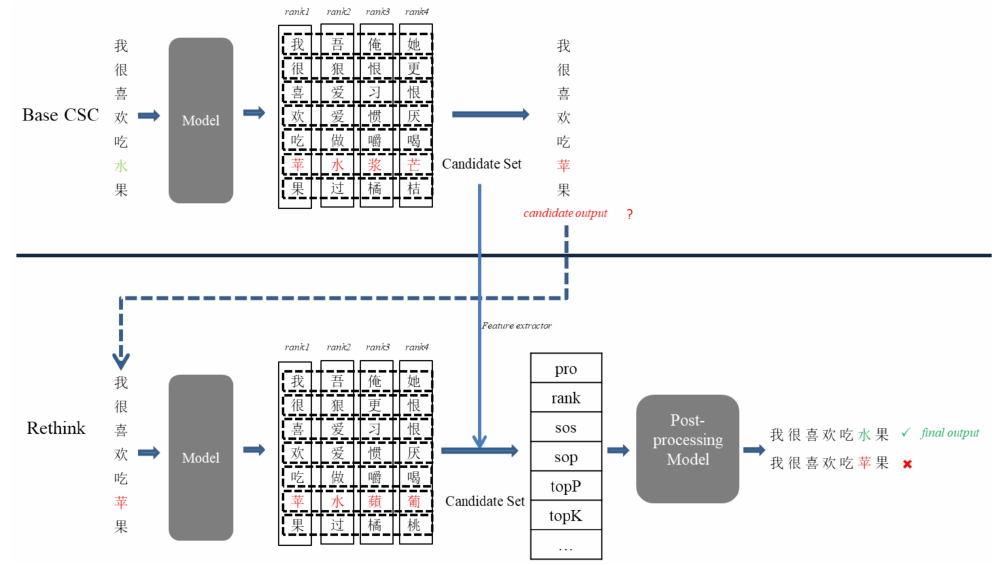
Figure 1. An example of introducing post-processing operation. The base model (the upper part of the figure) made a unnecessary change 水 to 苹 after correcting this sentence. However, for the PoP model (the lower part of the figure), we proposed avoided this